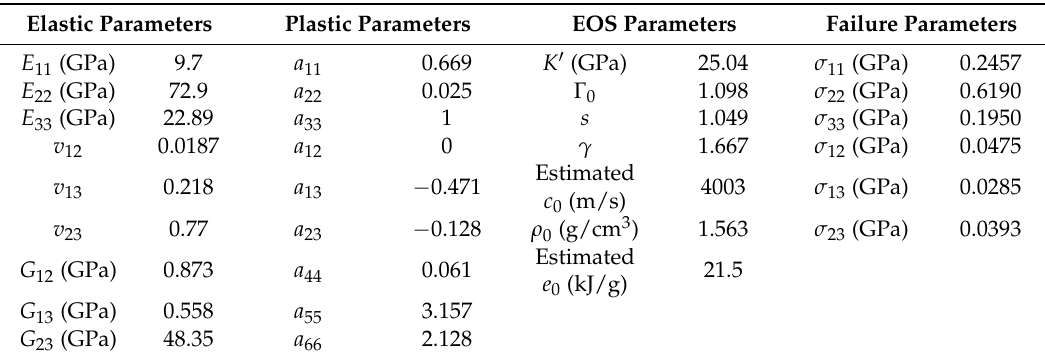
Table 1. Material properties of CFRP